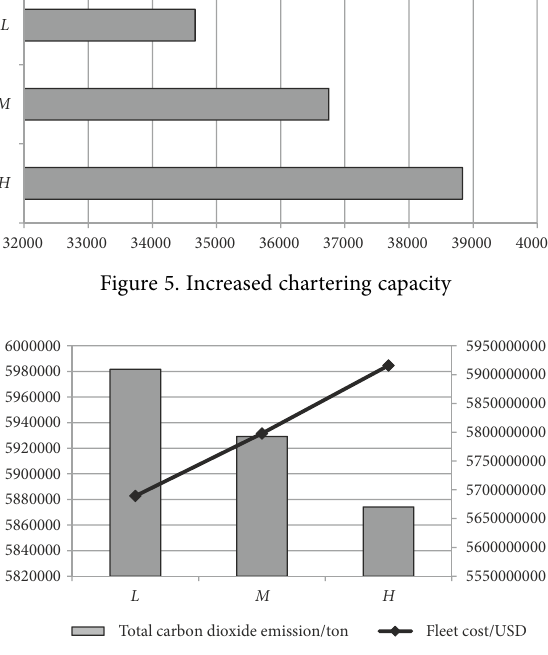
Figure 6. Optimization results from SP